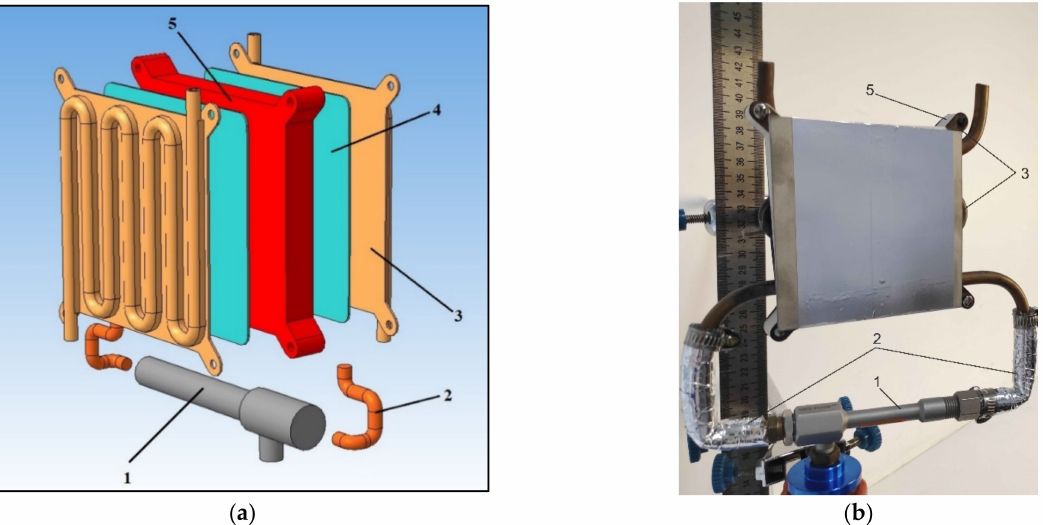
Figure 5. ( a ) Elements of the system for converting the energy of the gas flow into electrical energy; ( b ) system for converting the energy of the gas flow into electrical energy: 1—Ranque–Hilsch vortex tube; 2—connecting pipes; 3—plate of heat-conducting material with coil; 4—thermal pad; 5—thermoelectric